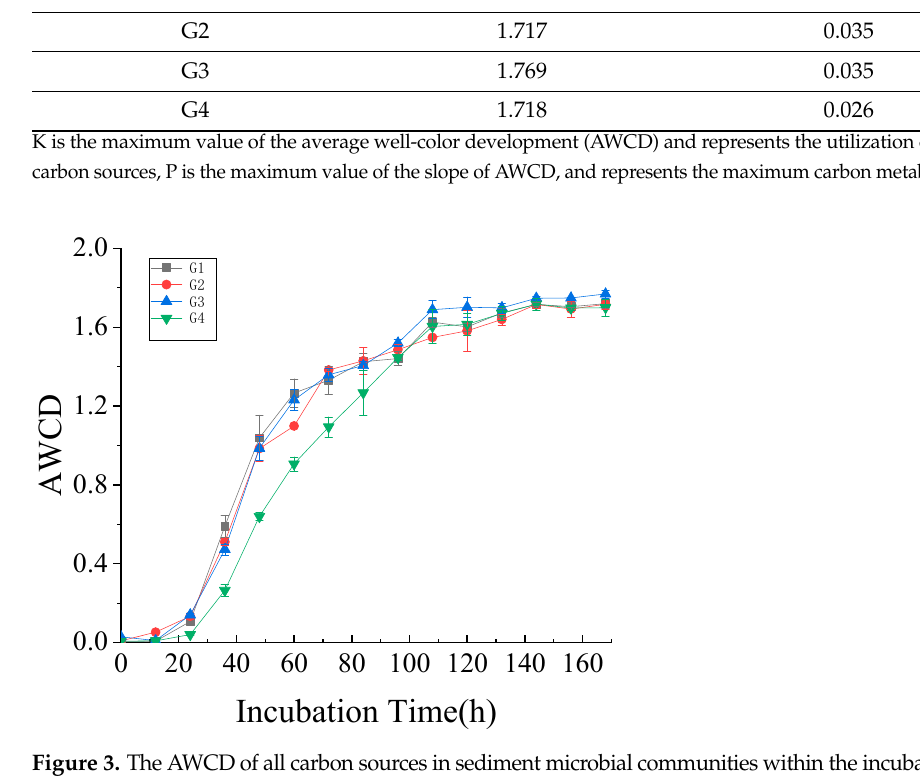
Figure 3. The AWCD of all carbon sources in sediment microbial communities within the incubation time.